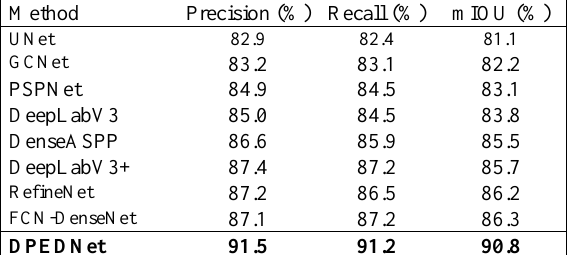
Table 3. Evaluation results on Crowded mapping challenge validation set with one channel image.